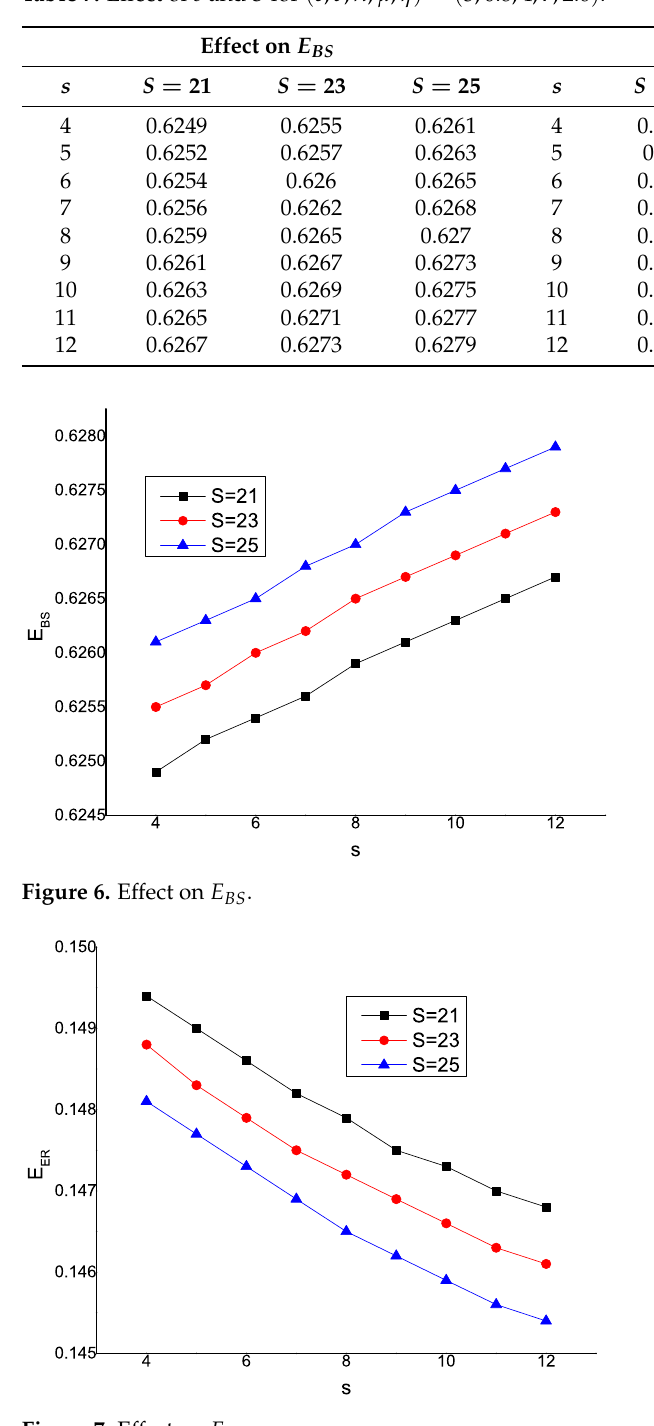
Figure 7. Effect on E ER